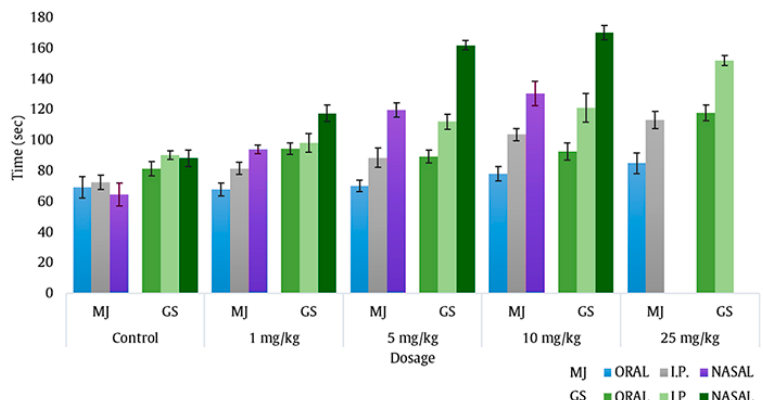
Figure 1. Effect of oral, i.p. and nasal route of administration of intranasal rosuvastatin (ROS) on mean latency to pentylenetetrazole (PTZ)-induced seizures; p > 0.5, nasal 5 mg/kg vs. nasal 10 mg/kg;